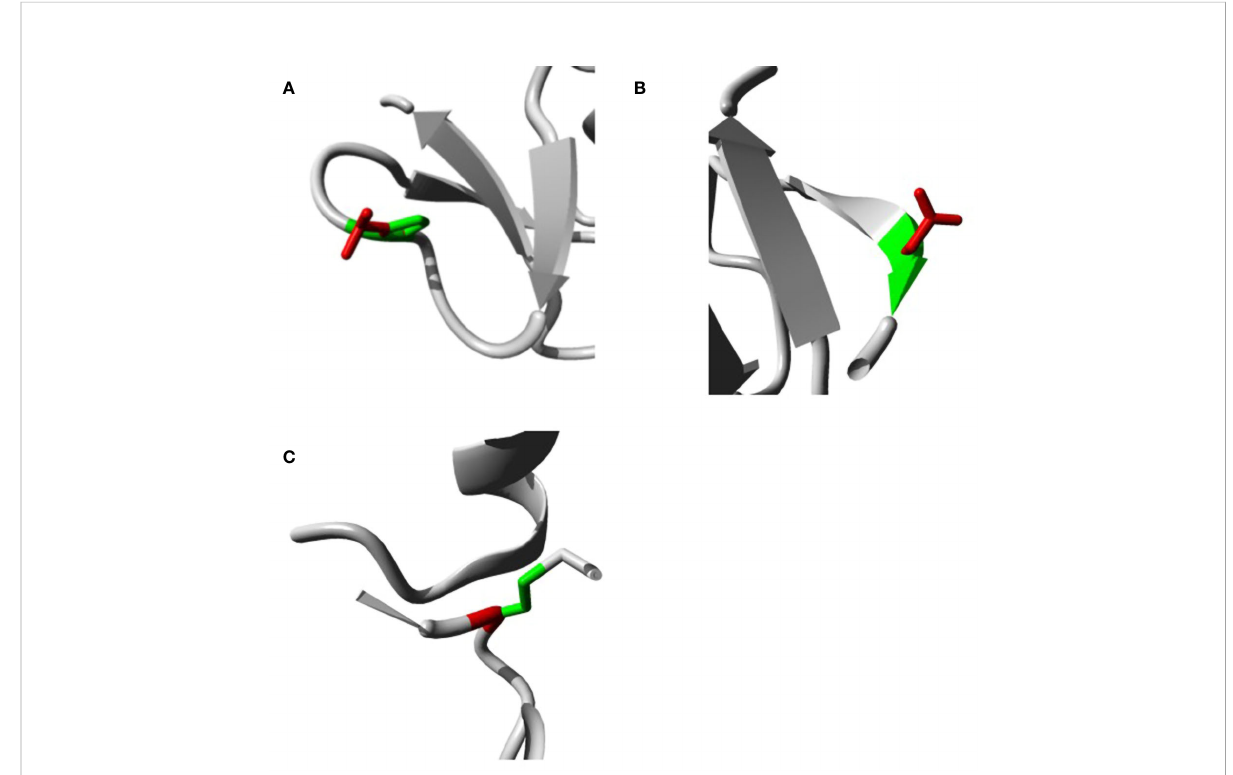
FIGURE 2 Impacts of SNPs on h BD2 3D structure as produced by the HOPE bioinformatics tool. (A) Impacts of SNPs on h BD-2 3D structure with P44L SNP. (B) Impacts of SNPs on the h BD-2 3D structure with G51D SNP. (C) Impacts of SNPs on the h BD-2 3D structure with C53G SNP.